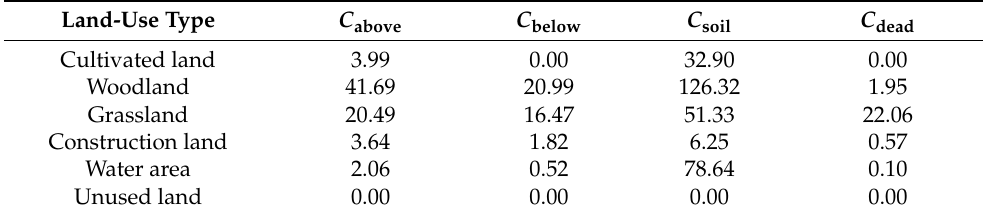
Table 2. The carbon storage per unit area of each LULC type. Land-Use Type C above C below C